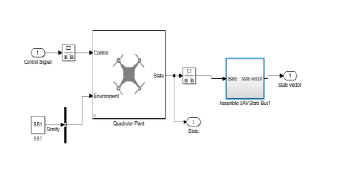
Figure 10. Basic design of Simulink and simulation of quadcopter plant.